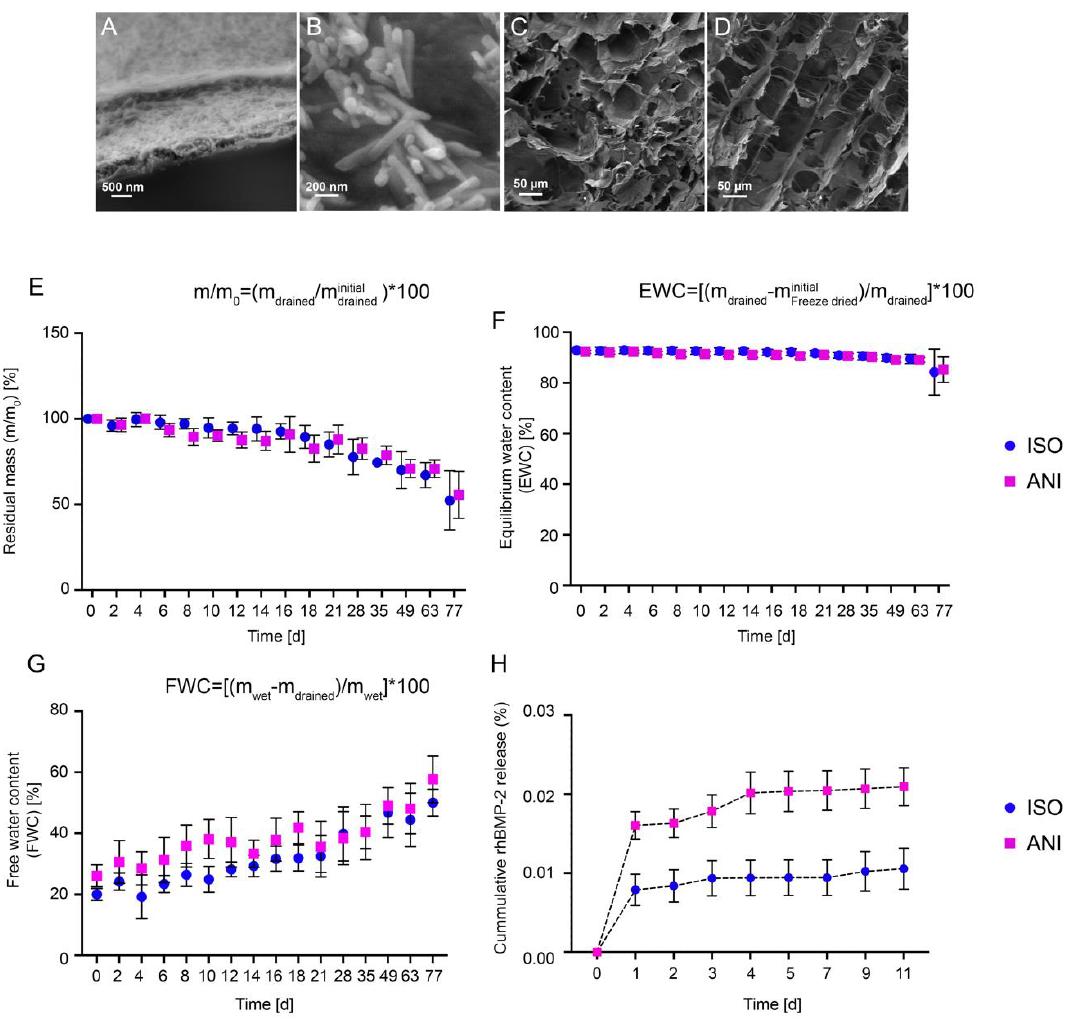
Figure 2. In vitro characterization of cryostructured bone sca ff olds. ( A – D ) scanning electron microscope (SEM) images: ( A ) Cross-sectional image of typical lamellae presenting a homogeneous composite structure of collagen and hydroxyapatite; ( B ) Representative sub-micron hydroxyapatite crystals adhered to the inner surface of both sca ff old types; ( C ) Cross section of the isotropic sca ff olds (ISO); ( D ) Cross section of anisotropic pore structures (ANI); ( E – G ) Degradation behavior of the bone sca ff olds under physiological conditions: ( E ) Residual mass (m / mo); ( F ) Equilibrium water content (EWC); ( G ) Free water content (FWC); ( H ) In vitro bone morphogenetic protein 2 (BMP–2) release from bone sca ff olds. ISO, sca ff old with isotropic pore structure; ANI, sca ff old with anisotropic pore structure.